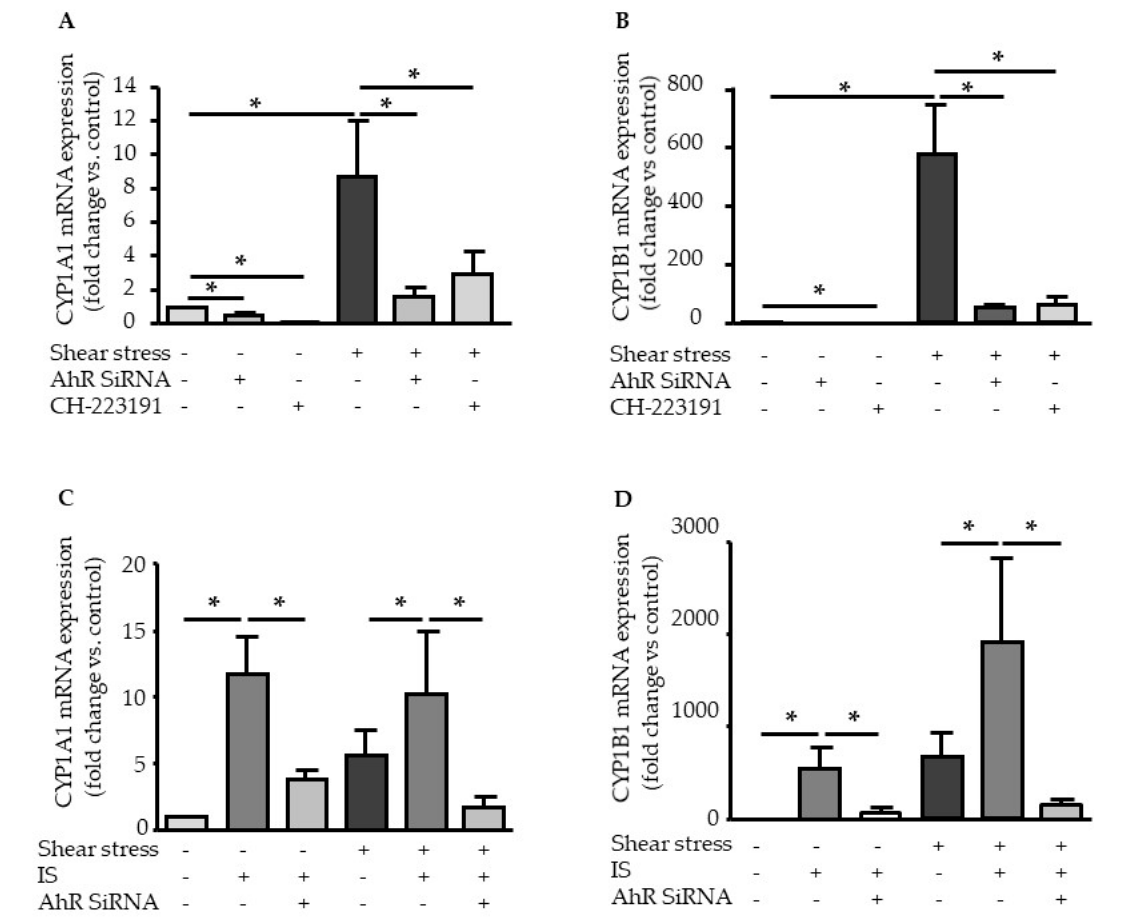
Figure 3. AHR-dependent additive e ff ects of shear stress and IS on CYP1A1 and CYP1B1 upregulations. E ff ect of the AHR inhibitor CH-223191 (10 µ M) and of AHR siRNA on mRNA expression of CYP1A1 ( A ) and CYP1B1 ( B ) after 4 h of shear stress (5 dynes / cm 2 ). Data represent the mean ± SEM of 5 independent experiments. E ff ect of AHR siRNA on mRNA expression of CYP1A1 ( C) and CYP1B1 ( D ) after a 4 h stimulation with IS 200 µ M. Data represent the mean ± SEM of 5 independent experiments. * p < 0.05.